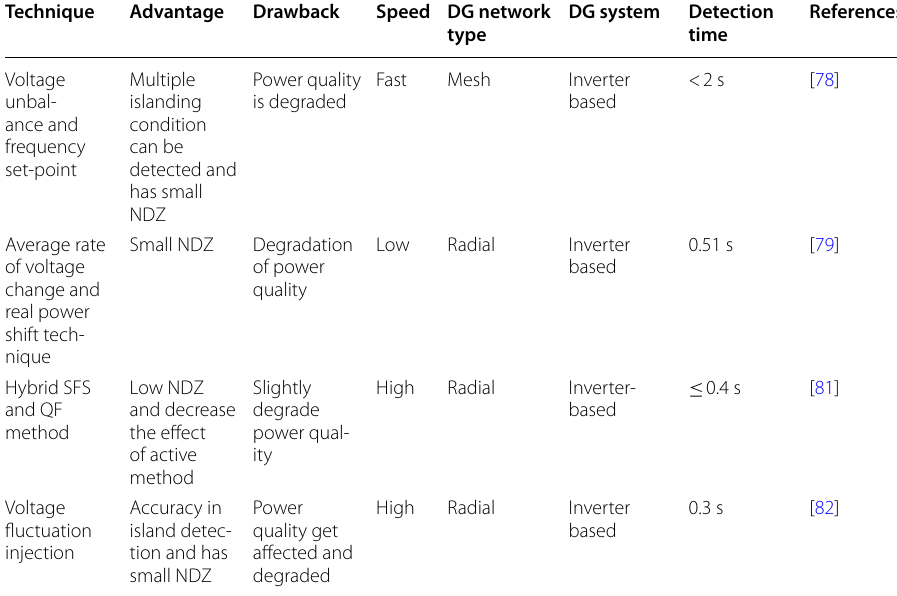
Table 4 Summary of various hybrid island detection technique